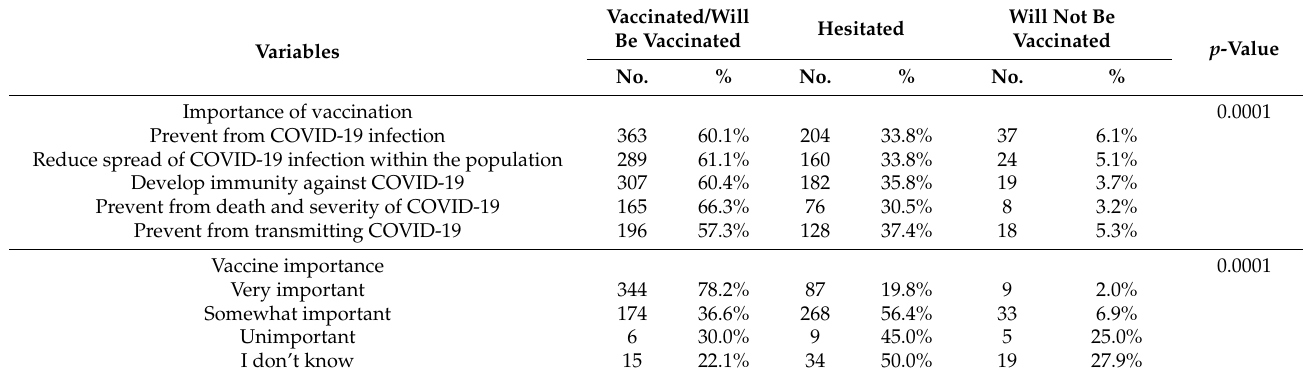
Table 9. Attitudes of survey responders on the importance of vaccinations measured by willingness to be vaccinated for COVID-19.